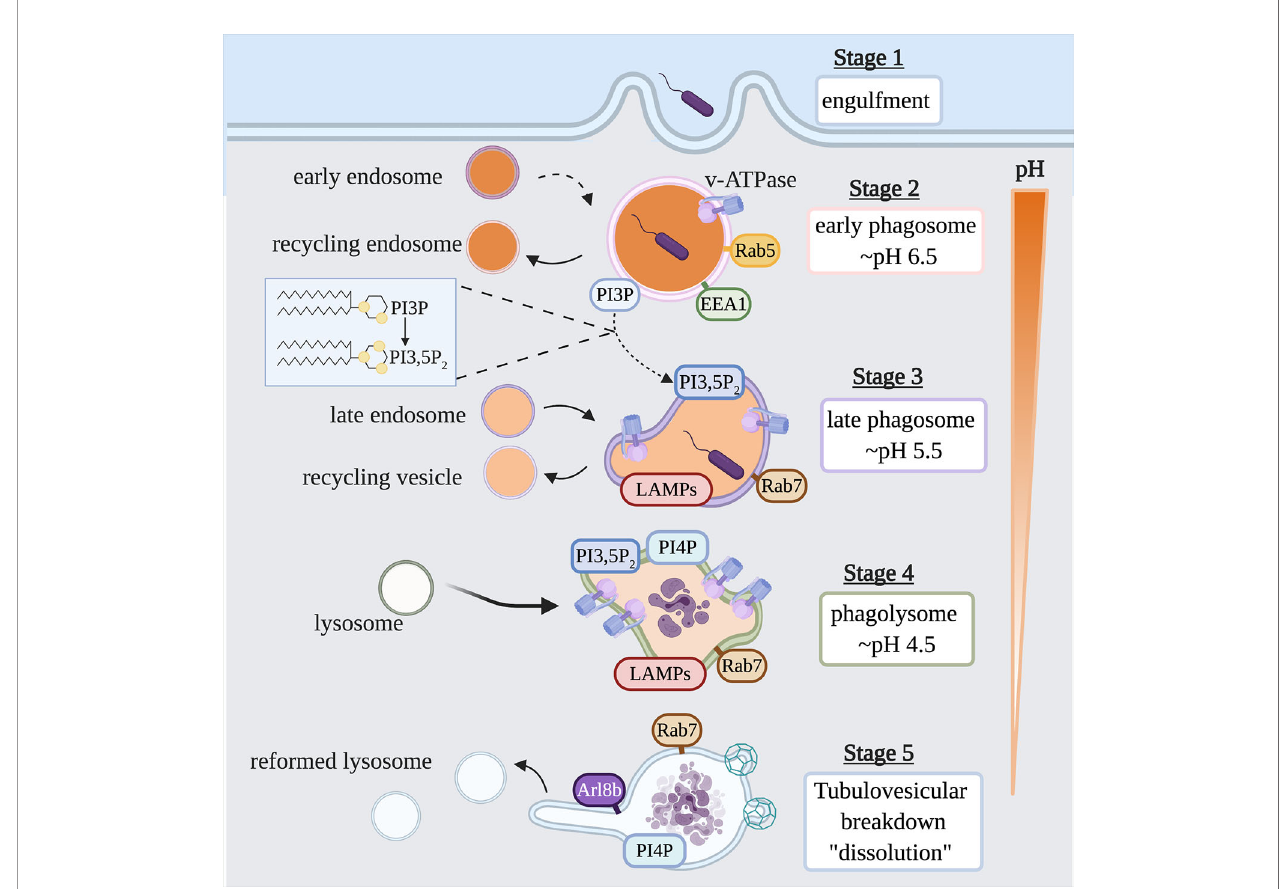
FIGURE 2 | Life Cycle of the Phagosome. Phagosomes are formed on demand when professional phagocytes encounter target particles such as, opsonized bacteria or apoptotic cells. Following internalization of a phagocytic target, the nascent phagosome is transformed into a microbiocidal vacuole through successive fusion and fi ssion events within the endocytic pathway. During this maturation process, the lumen of the phagosome is acidi fi ed by the action of v-ATPase, and also acquires hydrolases and other antimicrobial proteins. Key steps in the maturation process include the conversion from a Rab5-positive early phagosome to a Rab7- positive late phagosome; the acquisition of LAMP and v-ATPase; the conversion of PI3P to PI3,5P 2 ; and the appearance of PI4P. Once the particle within the phagolysosome has been degraded, PI4P- and Arl8b-dependent membrane tubulation and budding events breakdown the organelle, reforming lysosomes consumed in the maturation process. EEA1, early endosomal antigen 1; LAMP, lysosome-associated membrane protein; PI3P, phosphatidylinositol 3-phosphate; PI3,5P 2 , phosphatidylinositol 3,5- bisphosphate; PI4P, phosphatidylinositol 4-phosphate; Arl8b, ADP-ribosylation factor-like protein